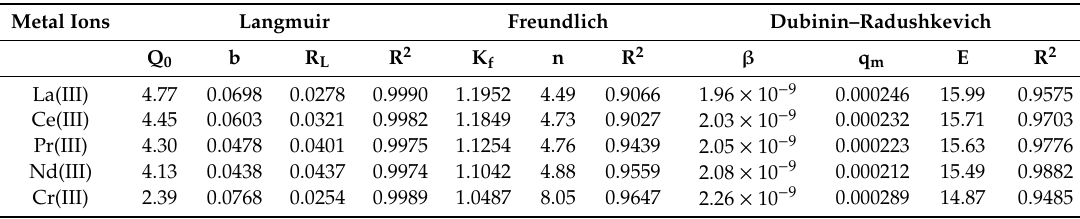
Table 4. The Langmuir, Freundlich and the D–R isotherm model constants and the determination coe ffi cients for Cr(III), La(III), Ce(III), Pr(III) and Nd(III) ions sorption on